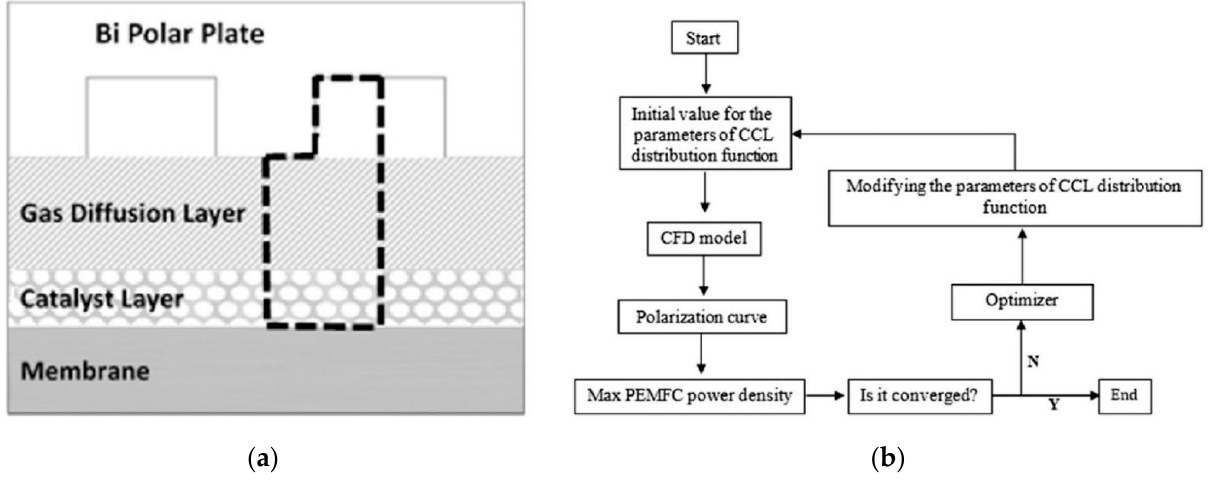
Figure 8. Numerical domain; ( a ) and overall optimization algorithm; ( b ) for power density optimization of a PEMFC [53].